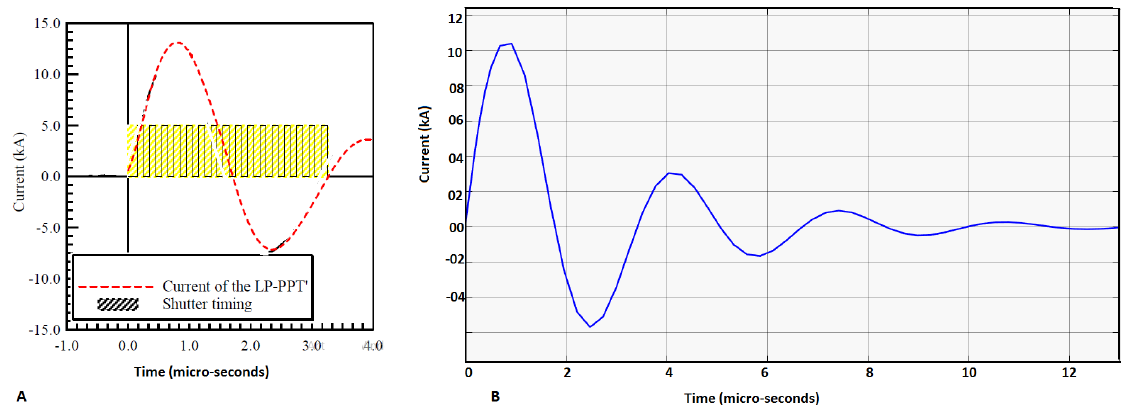
Figure 7. Discharge current for LPPT-2: ( A ) Experimental result [27]; ( B ) Simulation